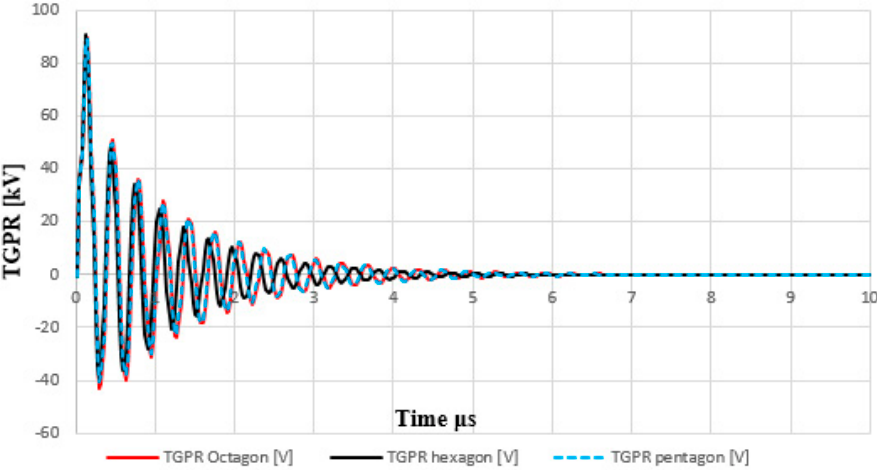
Figure 3. Transient ground potential rise during lightning surge scenario, pentagon-, hexagon-, and octagon-based geometries 10 µ s.